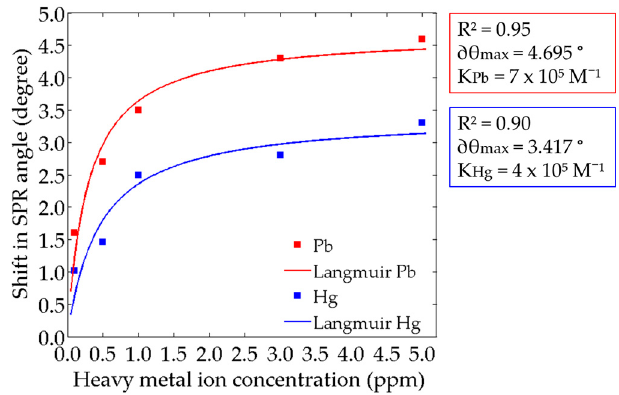
Figure 7. Langmuir isotherm model of the SPR angle shift for Pb 2+ and Hg 2+ ions.